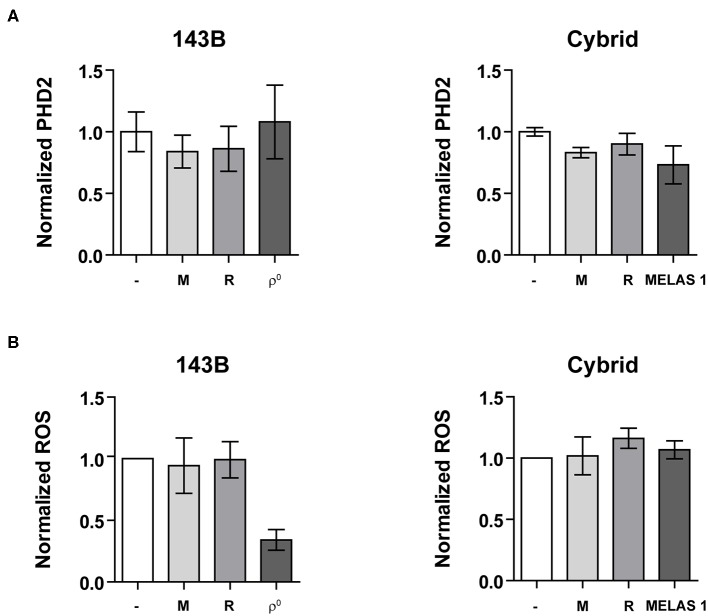
HIF-1α regulators. (A) Normalized PHD2 mRNA expression and (B) Normalized ROS production upon mtDNA depletion (left) or mtDNA mutation (right) under hypoxic conditions with or without OXPHOS CI inhibitors metformin (M) or rotenone (R). Data are normalized to either 143B (left) or ctrl 1 cybrid cell lines (right). Data represents the mean of ≥2 independent biological repeats ± SEM.